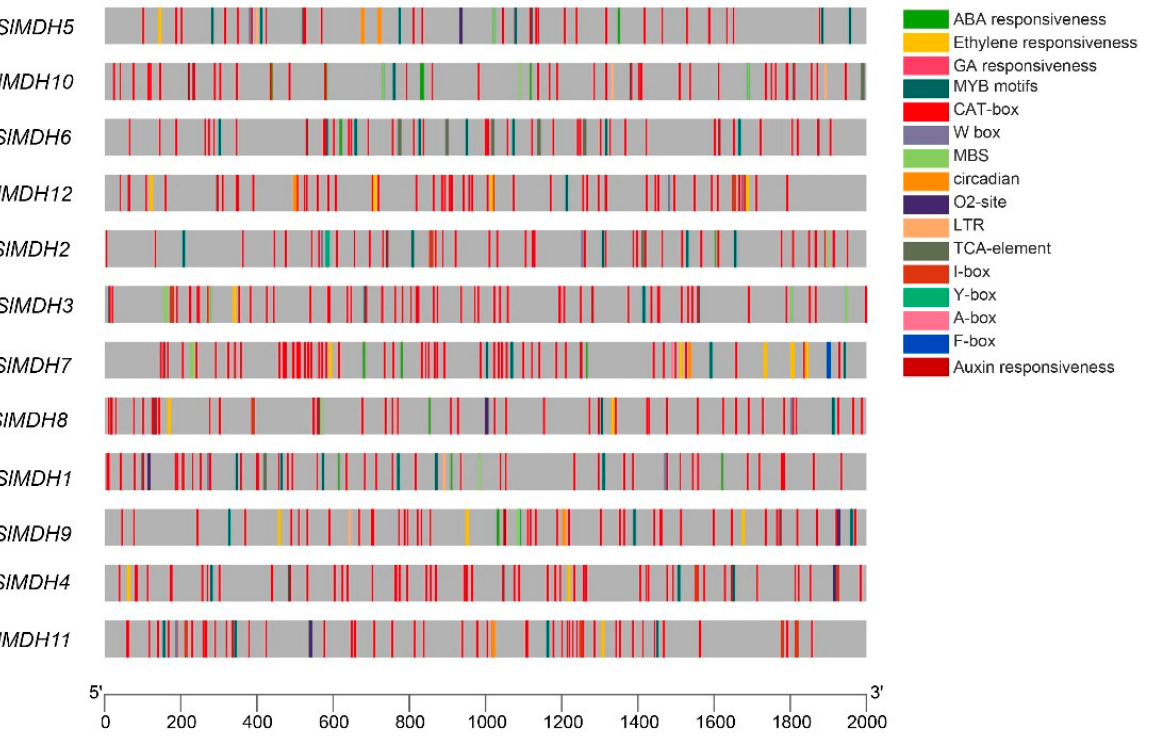
Figure 4. Cis -regulatory motifs found in the promoters of SlMDHs . Cis -elements are represented by various colored rectangles.